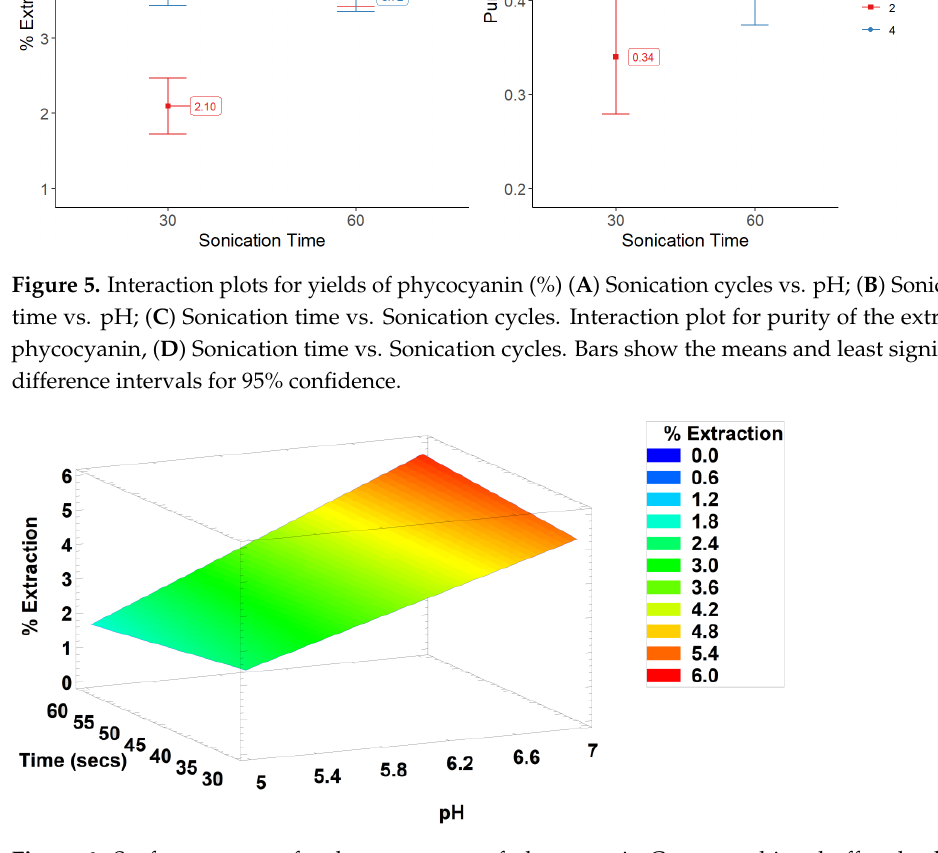
Figure 5. Interaction plots for yields of phycocyanin (%) ( A ) Sonication cycles vs. pH; ( B ) Sonication time vs. pH; ( C ) Sonication time vs. Sonication cycles. Interaction plot for purity of the extracted phycocyanin, ( D ) Sonication time vs. Sonication cycles. Bars show the means and least significant difference intervals for 95% confidence.